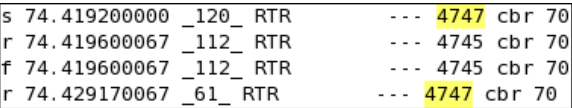
Figure 9. Packet transfer without encryption.